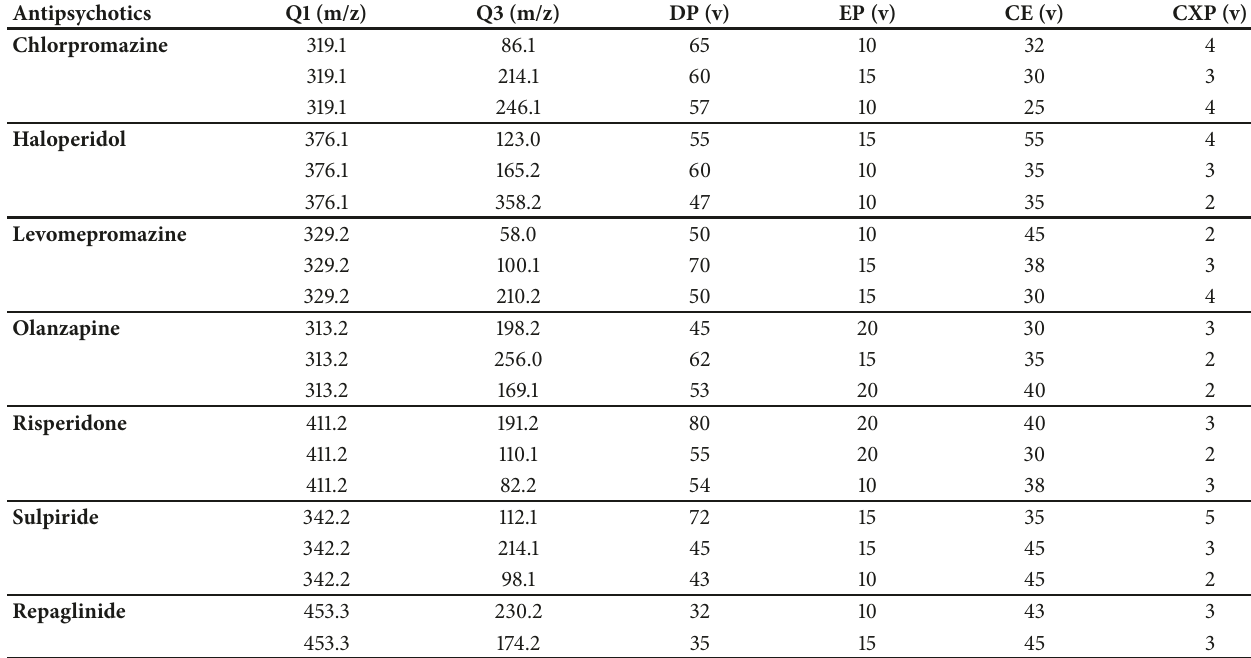
Table 2: Optimal compound related settings.